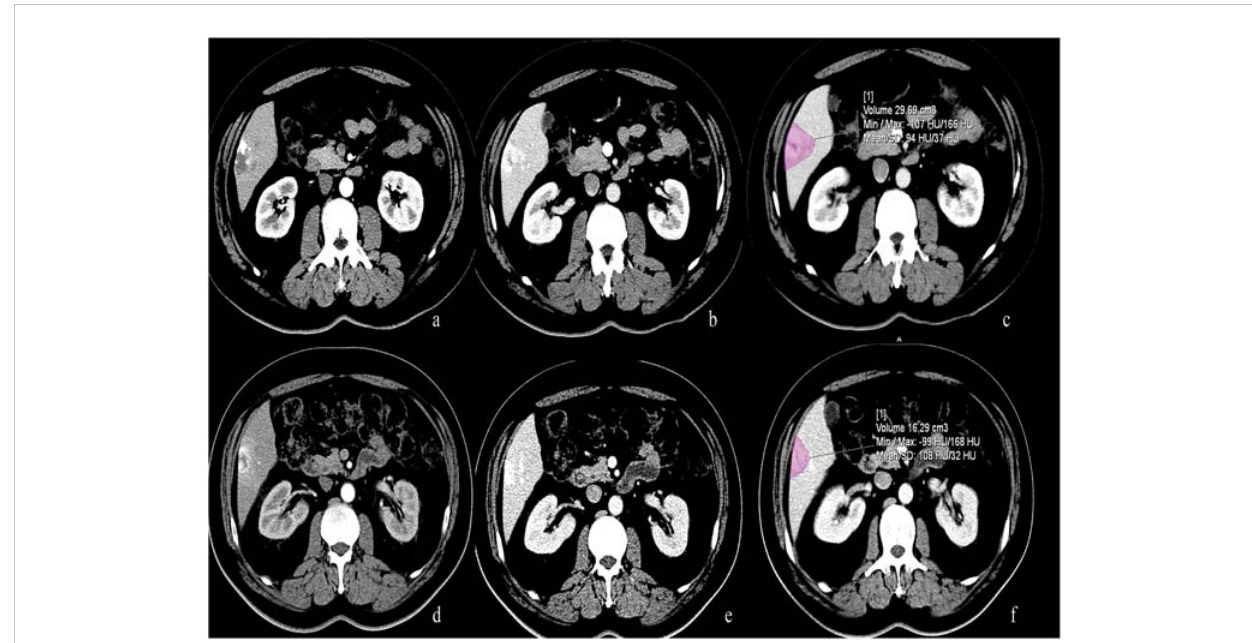
FIGURE 3 50-year-old male with lung cancer who received 5 cycles of treatment with bevacizumab. (A, B) Pre-treatment CT scan showed a typical hemangioma located at the liver segment 6. (C) The volume of this hemangioma measured 29.69 ml. (D – F) After treatment with Bevacizumab, the volume of this hemangioma decreased and measured 16.29